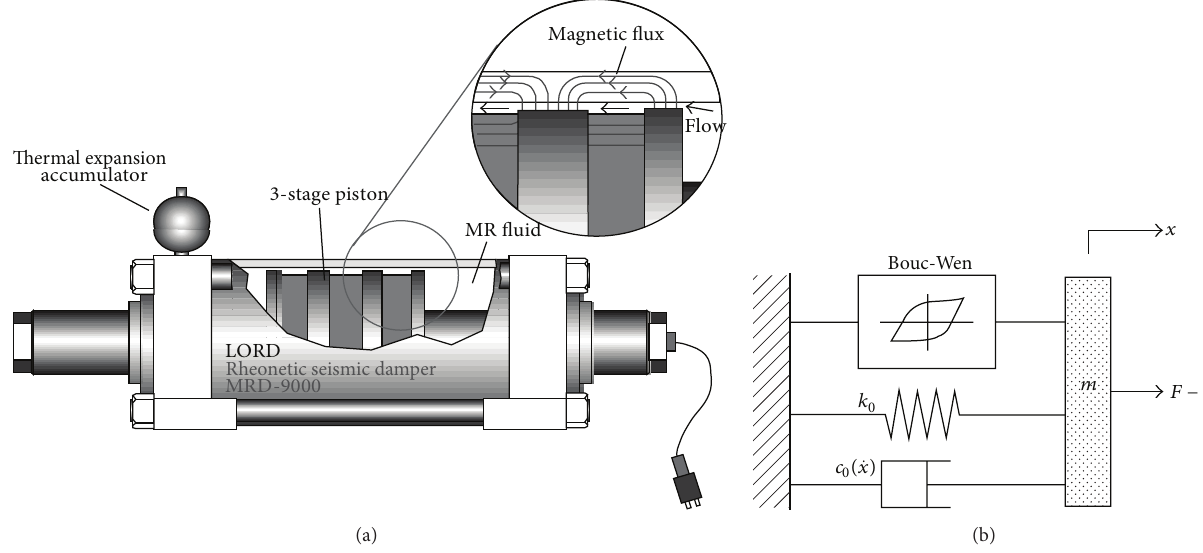
Figure 21: (a) Schematic of large-scale magnetorheological fluid damper; (b) Bouc-Wen model for large-scale MR dampers [15, 20].